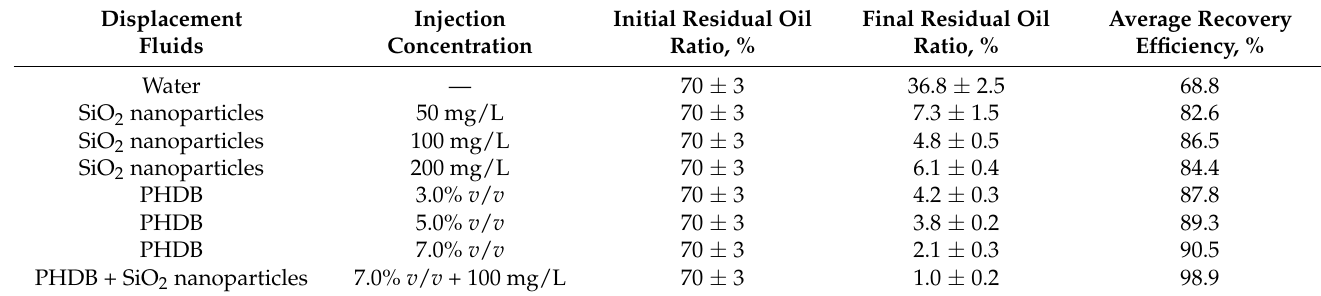
Table 2. Residual oil recovery efficiency under different displacement